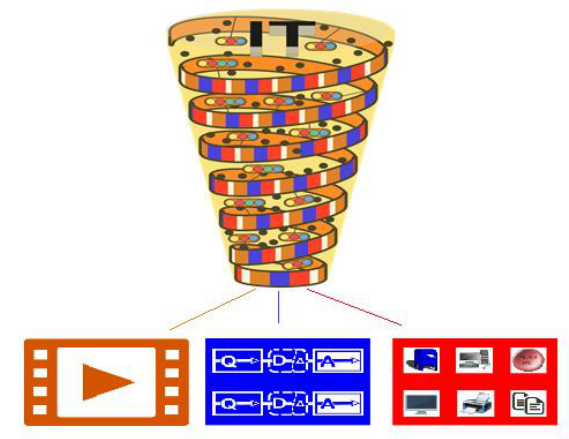
Fig. 8. General view of a new speech zone formation process in EAMS.